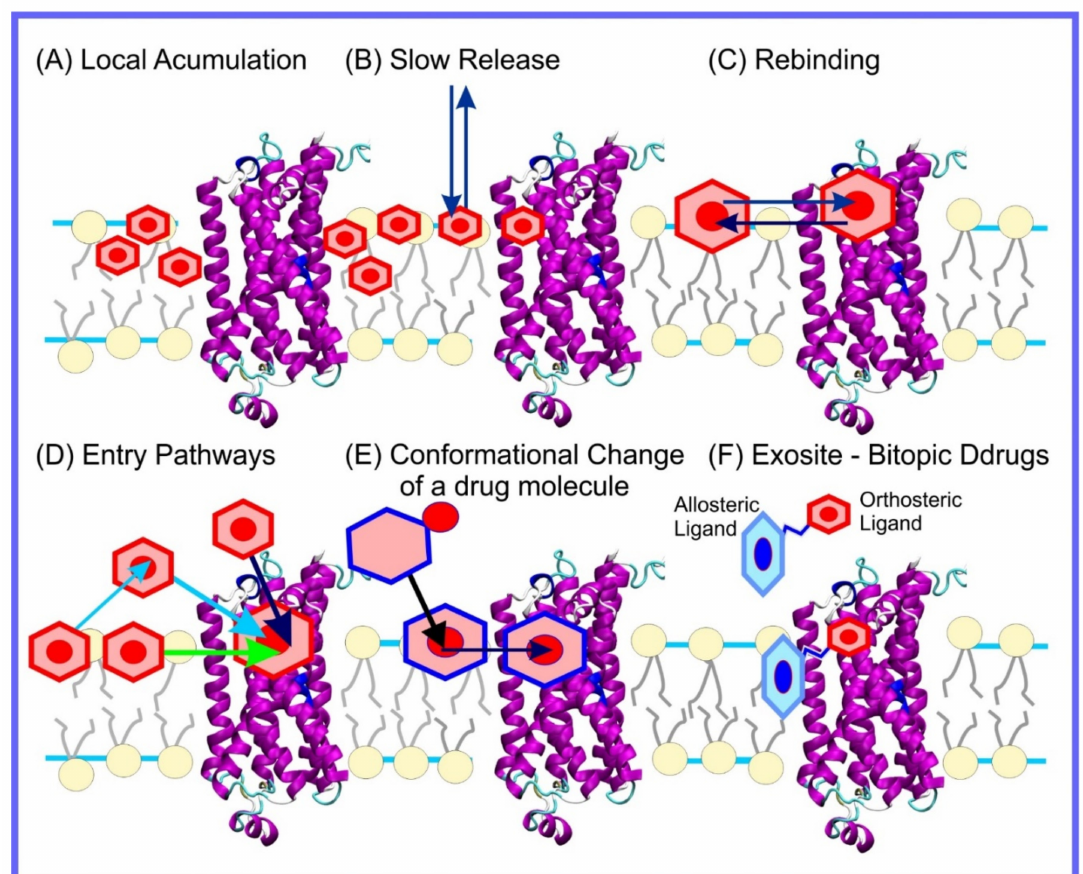
Figure 18. Accumulation of drugs in the membrane and its consequences for drug–protein interactions. Based on Figure 2 from ref.